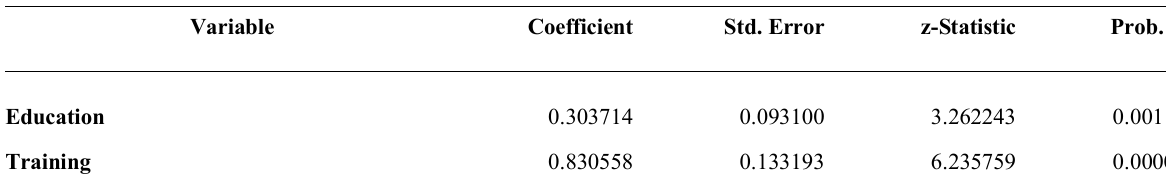
Table 4: Results of tobit estimation with omitted